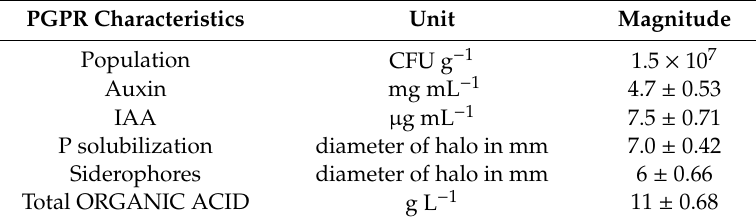
Table 3. Plant growth-promoting rhizobacterial (PGPR) characteristics of phosphate-solubilizing bacteria (PSB) used in the present